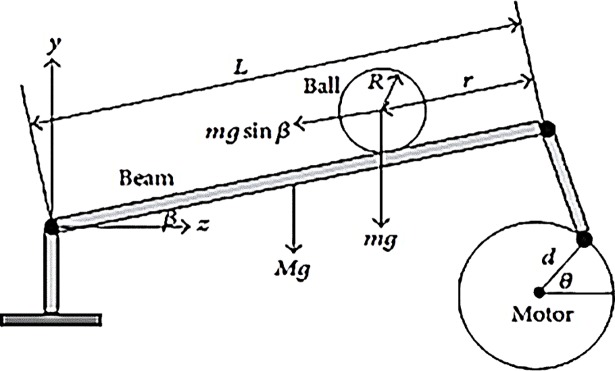
Ball and beam balancer schematic representation.